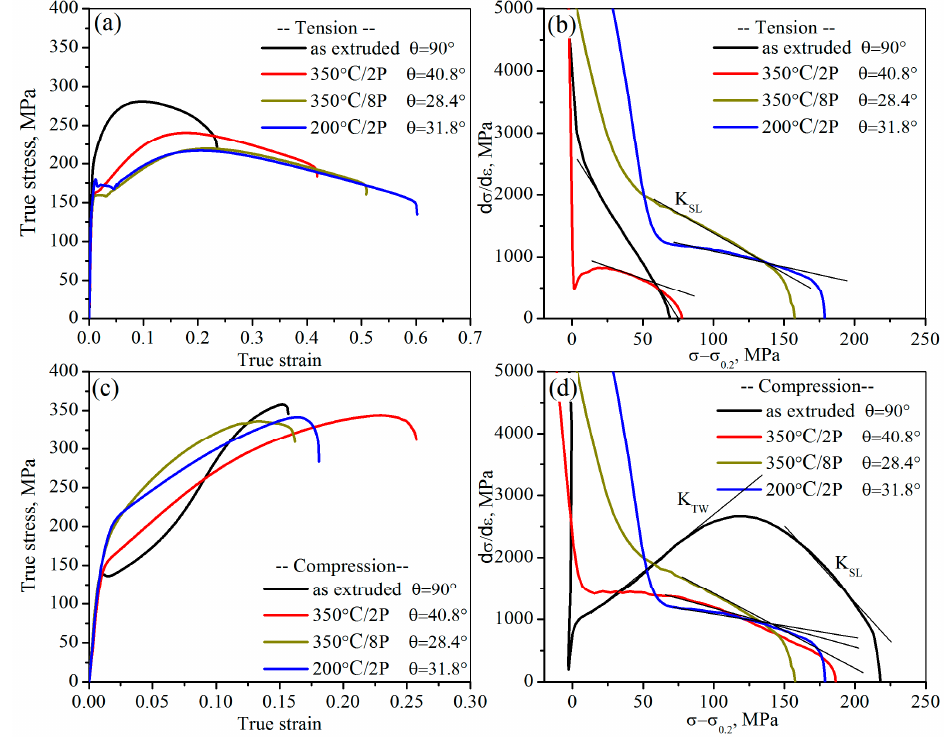
Figure 8. Room-temperature true stress-true strain curves and hardening curve for CECed ZK61 alloy rods in tension ( a , b ) and in compression ( c , d ).